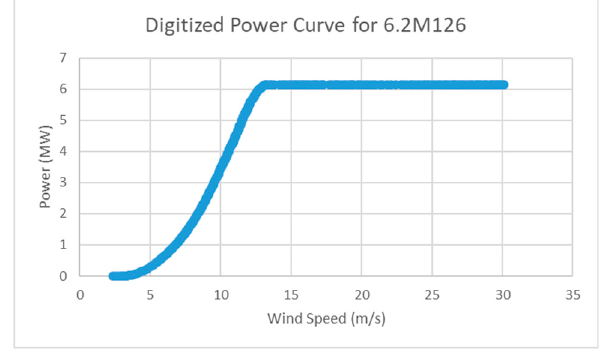
Figure 13. Power curve of Senvion 6.2M126.